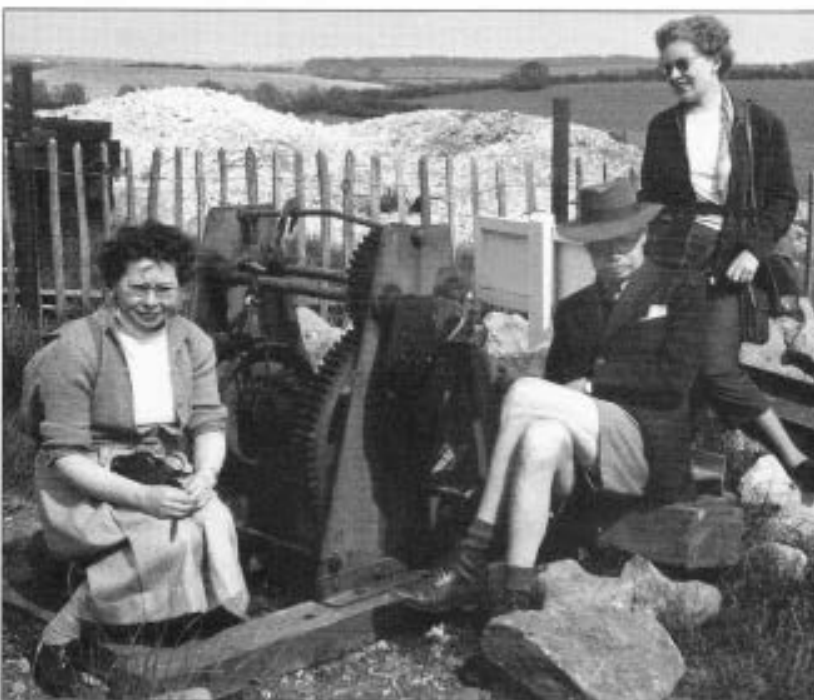
Figure 1 foan Sheldon (left) with Cordon Childe and an Institute student on a field excursion in 1956, during a visit to the West Kennet Neolithic chambered tomb near Avebury, Wiltshire, then being excavated by Richard Atkinson and Stuart Piggott. The pile of fresh chalk in the background is spoil from the excavation, and the mechanical device on which Childe is sitting was used to move heavy sarsen stones. 9